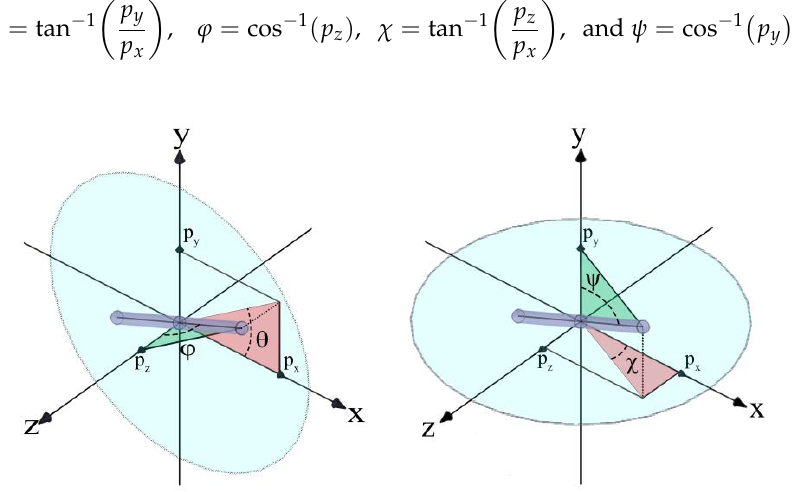
Figure 2. The orientation variables for a rod configuration. ( Left ) θ and ϕ as well as ( Right ) ψ and χ . Note that either set of θ and ϕ or ψ and χ determines the rod orientation p . The distribution of θ gives a unique feature (asymmetric distribution) of Brownian rod under shear flow. The distribution of ψ is directly related to the geometrical constraint by the weak confinement.